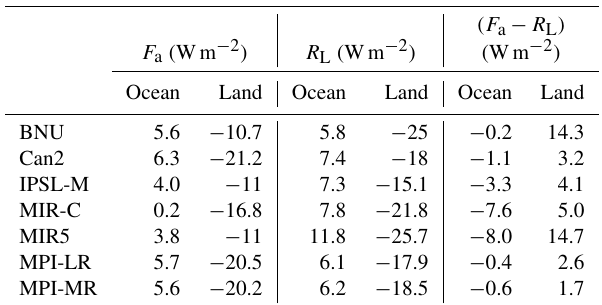
Table 5. Annual mean land–ocean asymmetries for atmospheric, latent energy budget and the difference of the two, for 20 years of multi-model ensemble simulations under piC conditions. Values are in watts per square